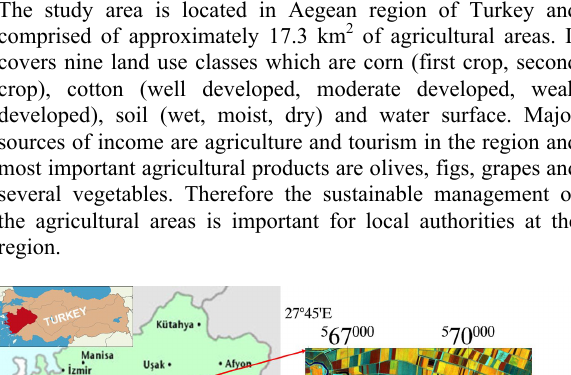
Table 2.Vegetation (Spectral) indices